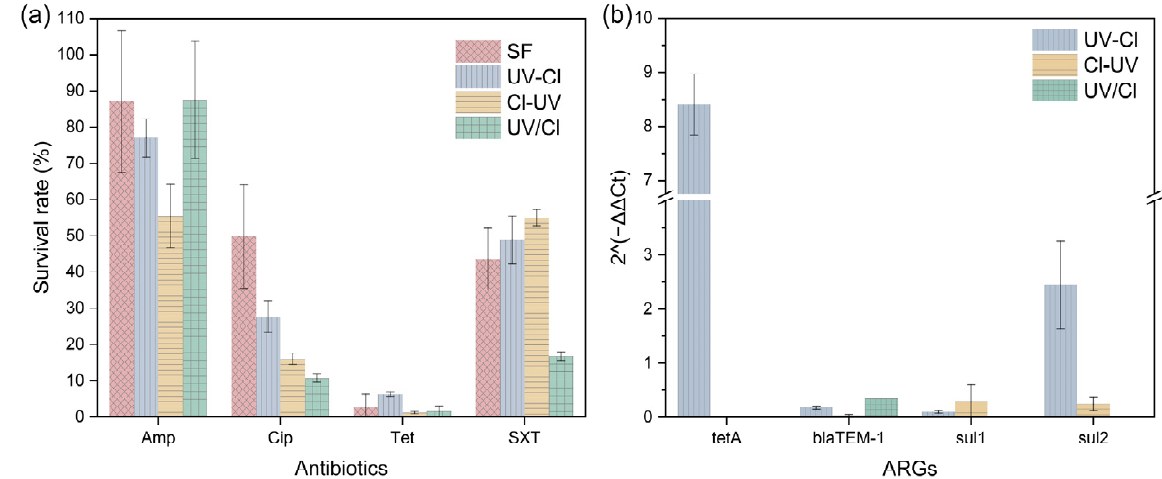
Figure 7. Percentage of culturable ARB ( a ) and relative abundance of ARGs ( b ) in biofilm. Four out of seven target genes were detected in biofilm samples and relatively quanti- fied (Figure 7b), while the functional genes ( intl1 , intl2 ) and other ARGs (i.e., oqxB , mexB , adeA , qnrS ) were below detection limits in all reactors. Generally, the contents of ARGs in the biofilm could be reduced by the combined processes with the majority of calculated ∆∆ Ct 2 − < 1. However, the contents of tetA and sul2 in the biofilm were increased after UV-Cl, implying a potential risk of enriching ARGs. Some results of ARGs could explain the ob- served culturable ARB (Figure 7a): the content of tetA in UV-Cl was much higher compared to that of SF, which is consistent with the higher Tet-resistance of biofilm bacteria in UV-Cl (6.3%) than those in other reactors (<2.5%). The sulfamethoxazole resistance genes, sul1